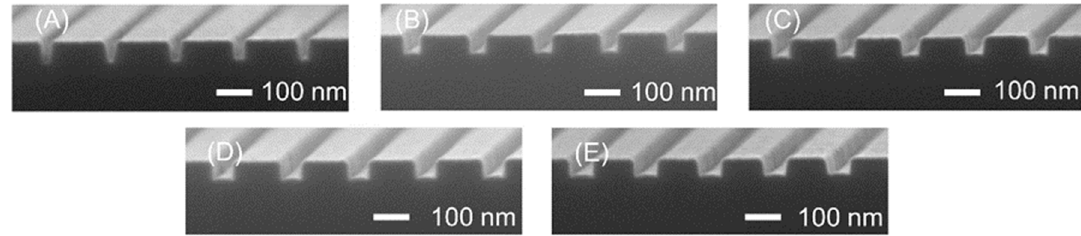
Figure 3. SEM images of nanochannels fabricated using exposure times of ( A ) 0.4, ( B ) 0.5, ( C ) 0.6, ( D ) 0.7 and ( E ) 0.8 μ s/dot.